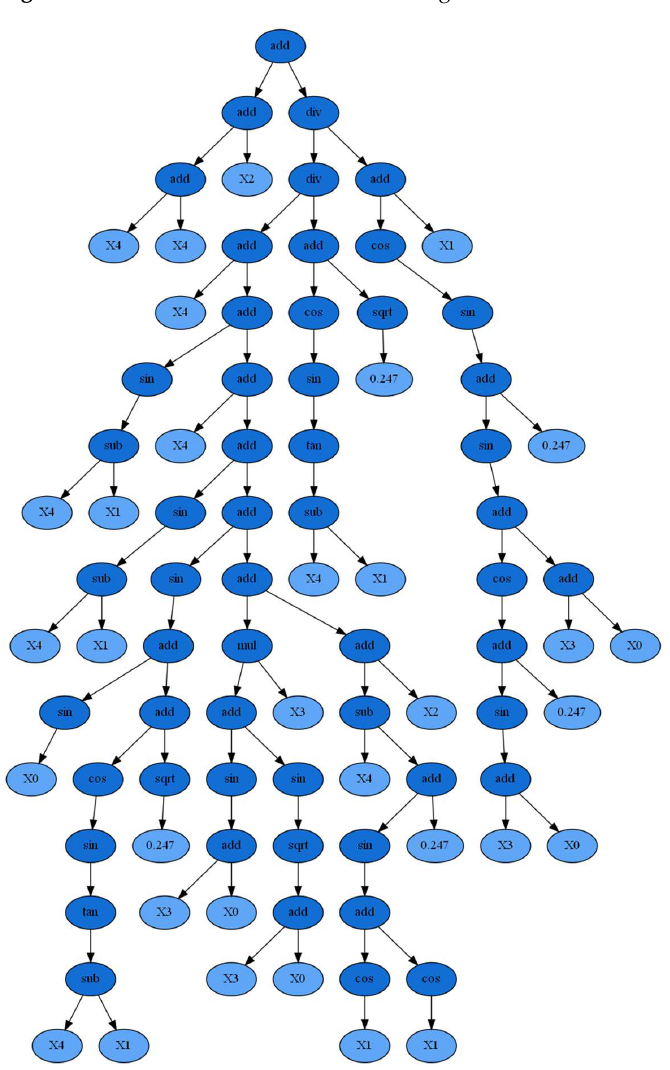
Figure 7. Tree structure representation of optimal results (X0 = LOP; X1 = PD; X2 = IC; X3 = Su; X4 = T).